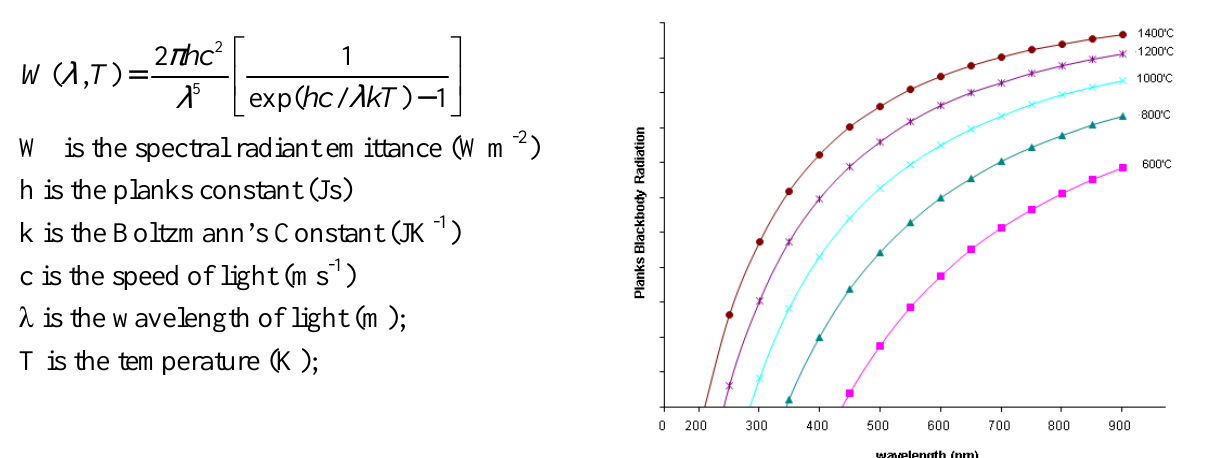
Figure 31. Distribution of blackbody radiation at different temperatures.